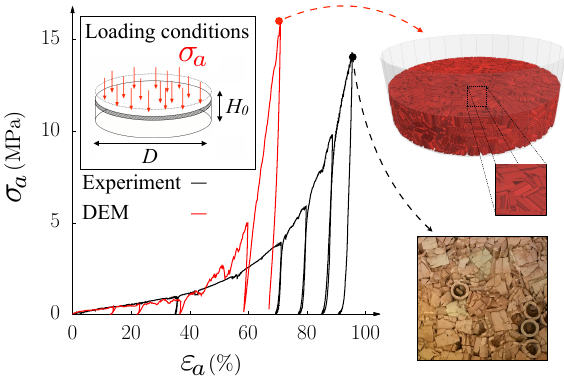
Figure 2. Comparison of the macroscopic mechanical behaviour to oedometeric compression. The experiment was performed at Euro-Géomat-Consulting on a sample with size: D = 30 cm and H 0 13 cm [12]. Equivalent DEM packing of 1 926 clus- ⇡ ters, that is 23 112 sectors; Figure 1(b). Right-side insets present crushing at the final